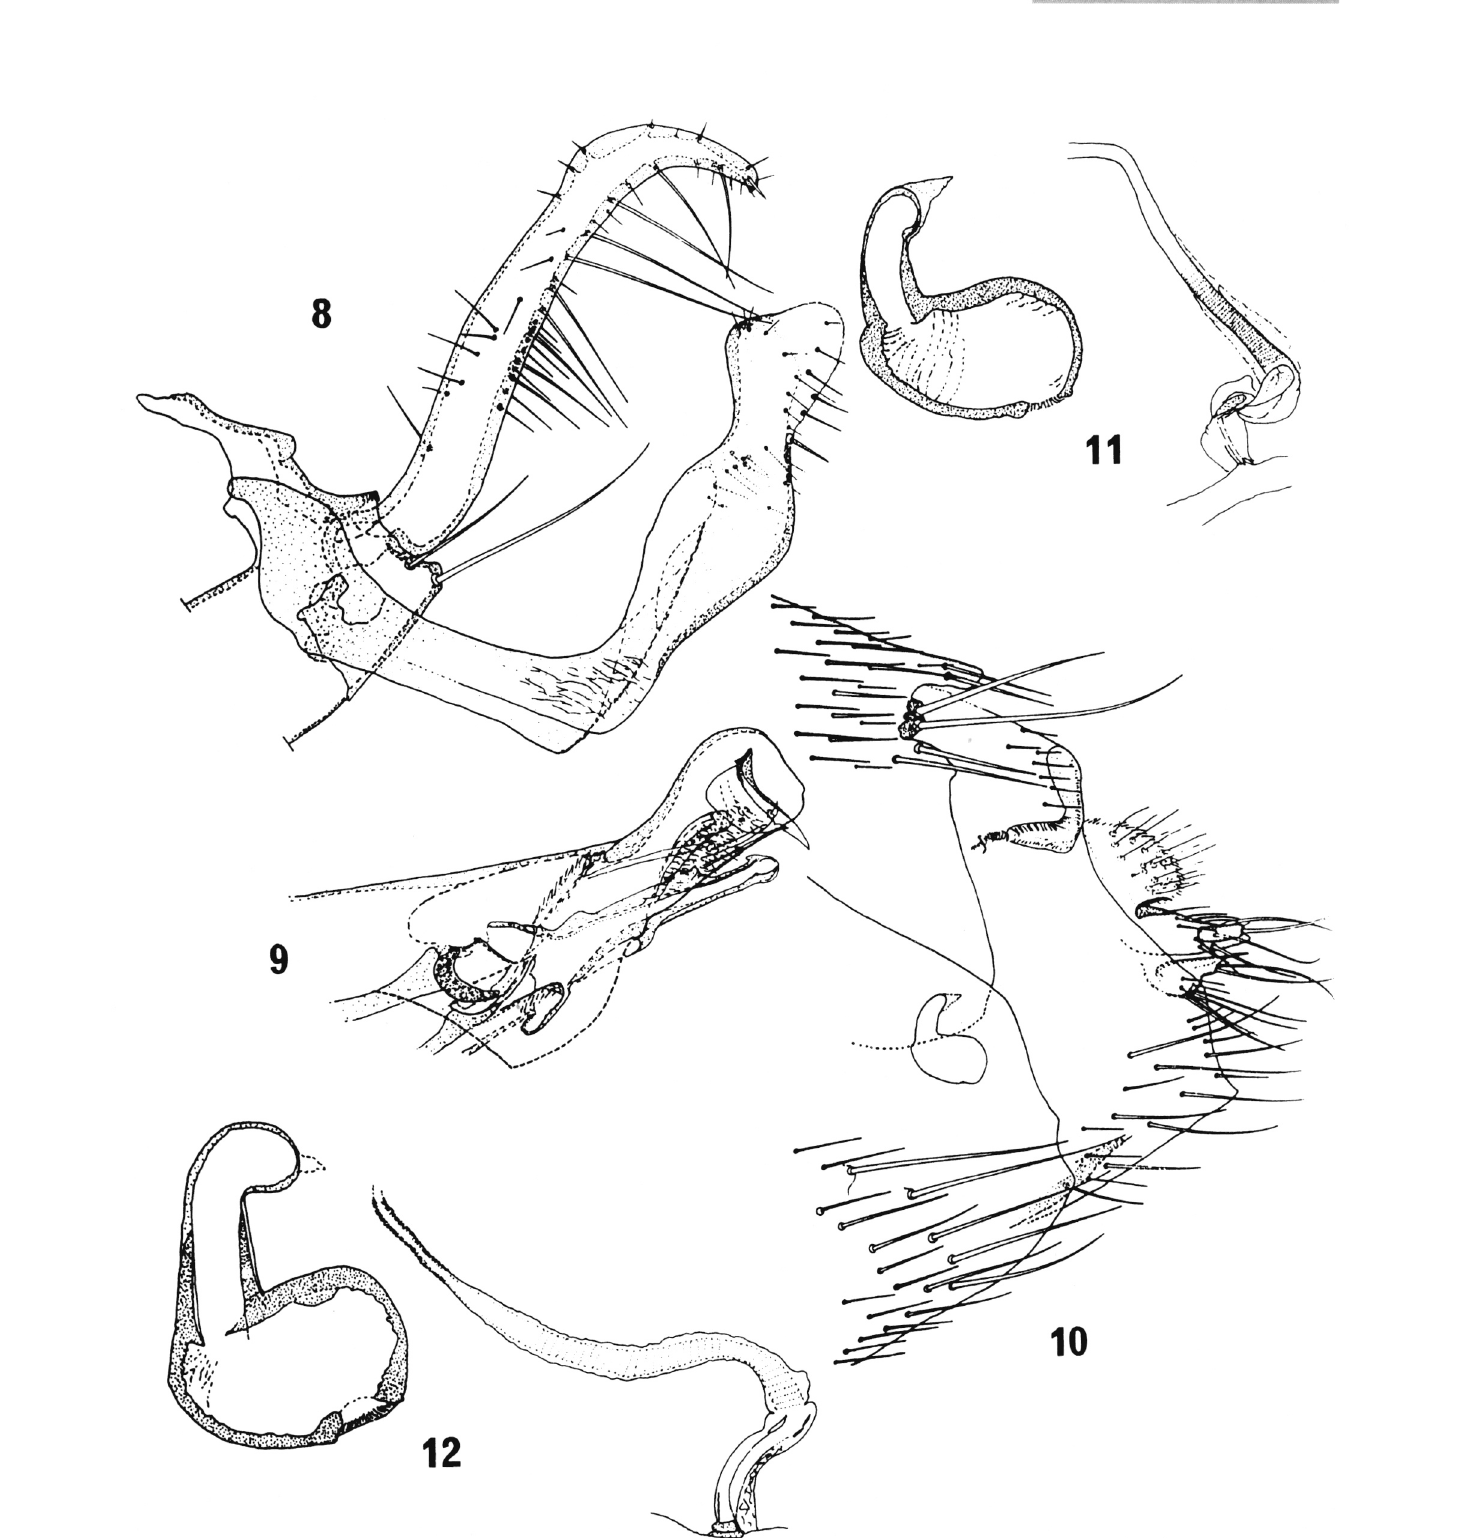
Figs 8-12. - Gymnomeropsylla Durden & Beaucournu, n. gen. 8: G. bunomydis Beaucournu & Durden, n. sp., segment IX (holotype male); 9: G. bunomydis, phallosome (paratype male); 10: G. bunomydis, segments VII, VIII and IX (allotype female); 11: G. bunomydis, sper- matheca and ducti (allotype female); 12: G. margaretamydis Durden & Beaucournu, n. sp., spermatheca and ducti (allotype female).